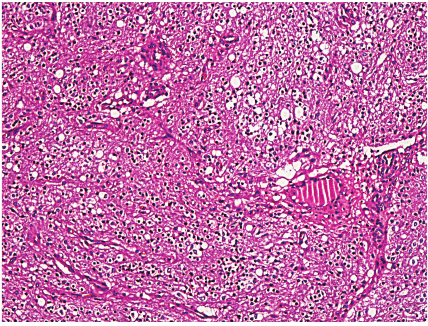
Figure 2: The sections showing a monotonous population of round, uniform cells with a hyperchromatic nucleus and perinuclear halo.